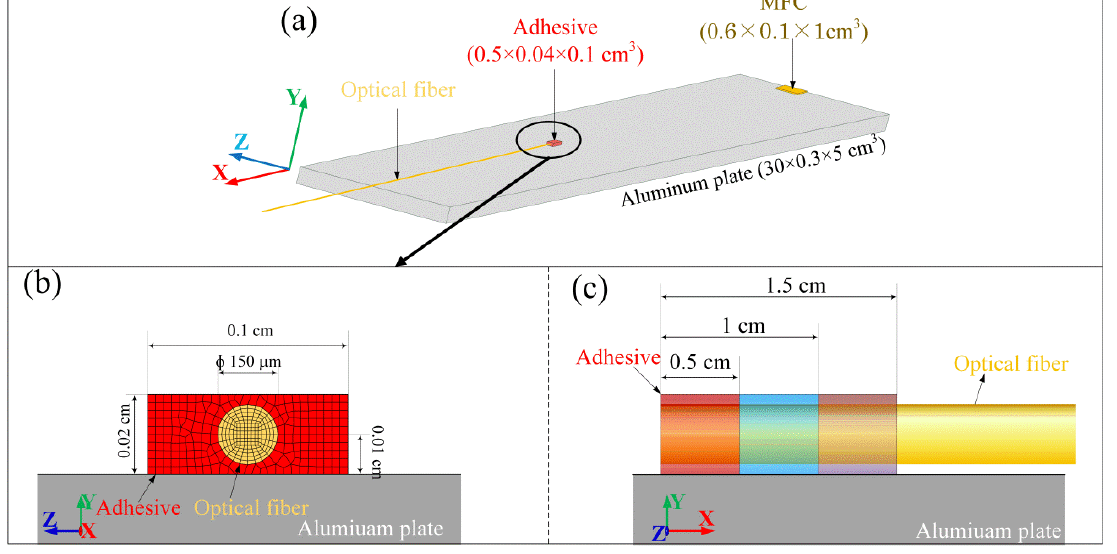
Figure 9. ( a ) 3-D FEM model; ( b ) model corresponding to the adhesive point; and ( c ) model for examining the influence caused by different adhesive lengths.